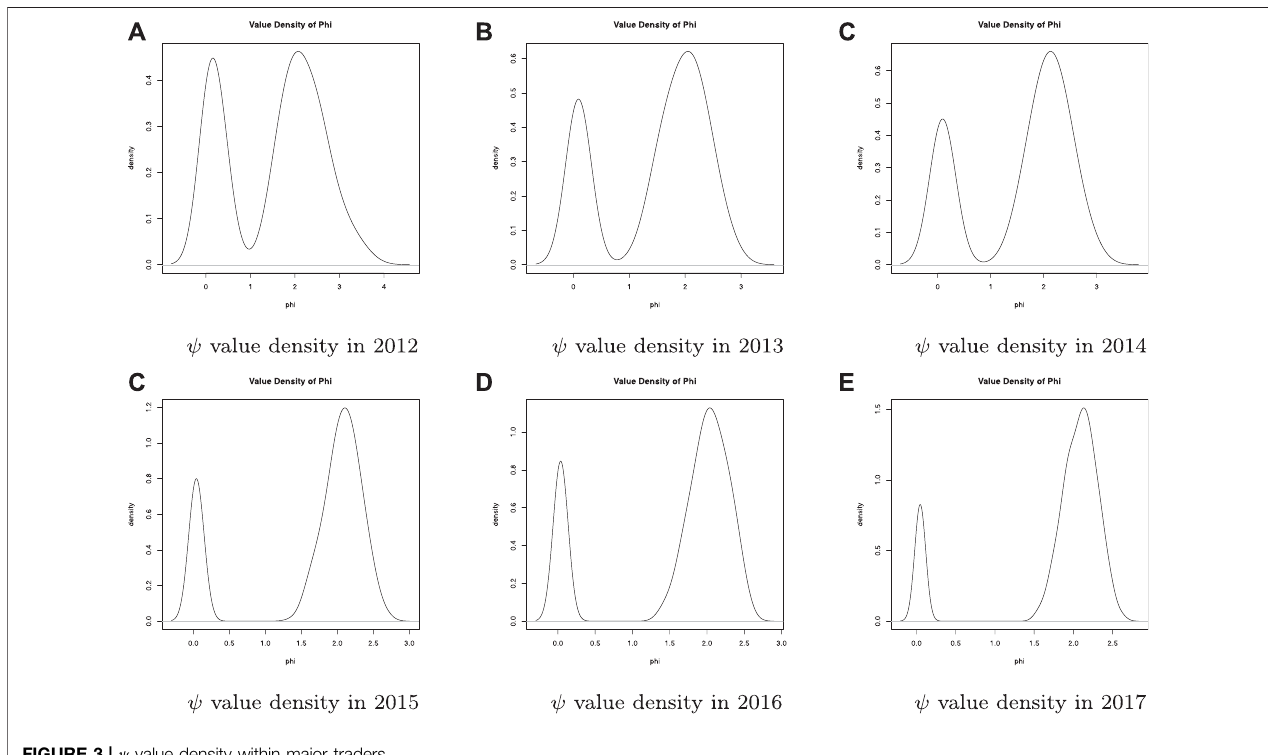
FIGURE 3 | ψ value density within major